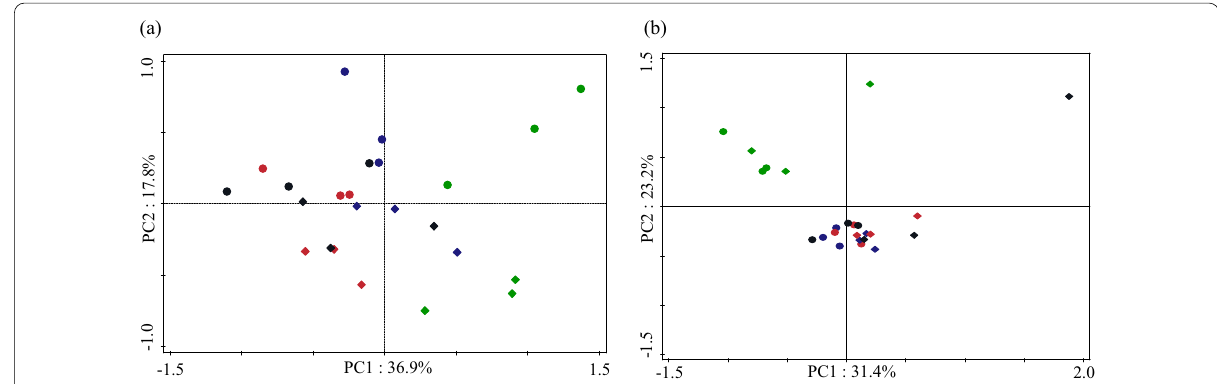
Fig. 4 Compositions of ( a ) bacterial and ( b ) fungal communities in forest litter and soil of the monoculture Larix gmelinii plantation (PL) and mixed L. gmelinii – Fraxinus mandshurica plantation (LF), as analyzed via principal component analysis. Circular shape, L. gmelinii plantation; diamond shape, mixed L. gmelinii – F. mandshurica plantation. Green, litter; blue, 0–10 cm soil layer; red, 10–20 cm soil layer; black, 20–30 cm soil layer